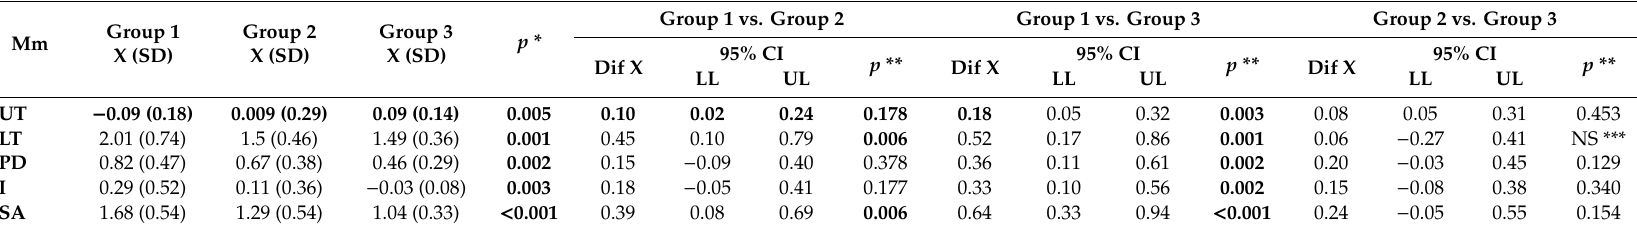
Table 4. Onset of muscle activity. External rotation movement.